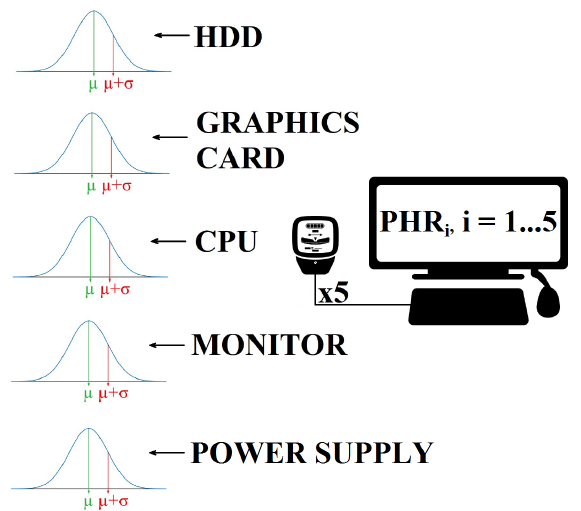
Figure 5. Process followed when measuring the power